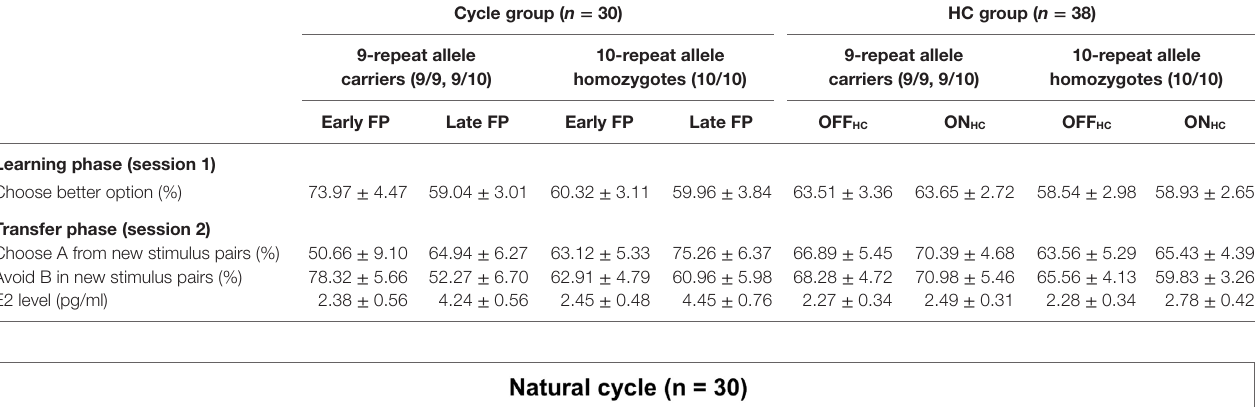
Table 2 | Descriptive statistics (arithmetic mean ± SEM) of choices during reinforcement learning (session 1) and in the transfer phase (session 2), as well as current E2 level subdivided by study group, DAT1-genotype, and